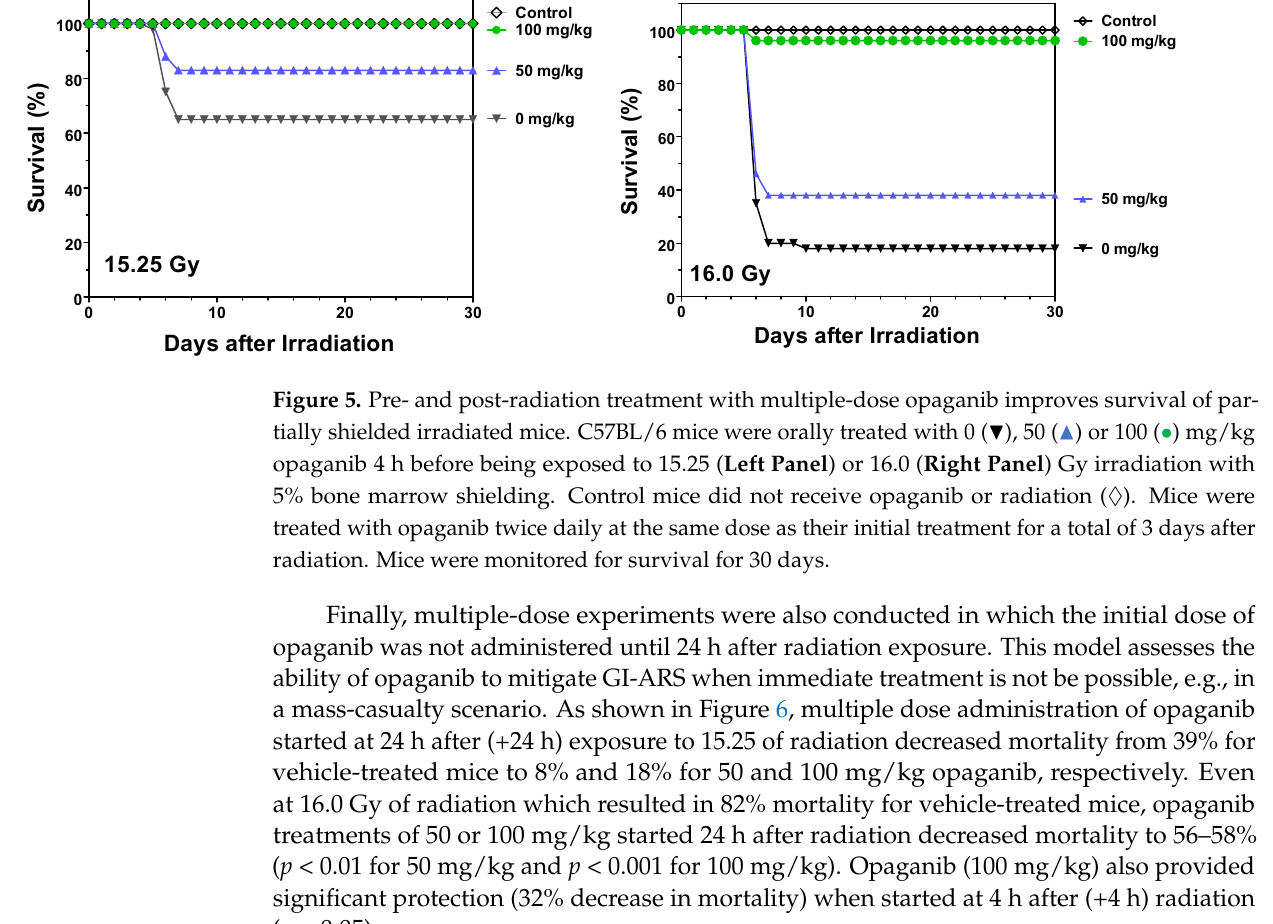
started at 4 h after (+4 h) radiation ( p < 0.05).